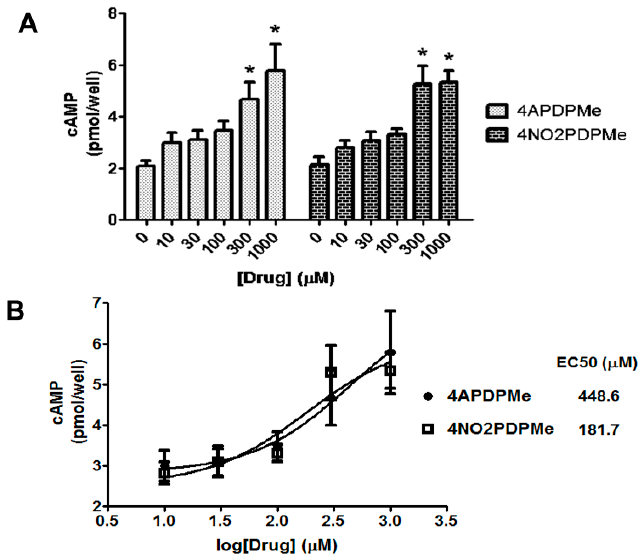
Figure 4. Intracellular cAMP levels induced by thalidomide analogs in HeLa cells. ( A )